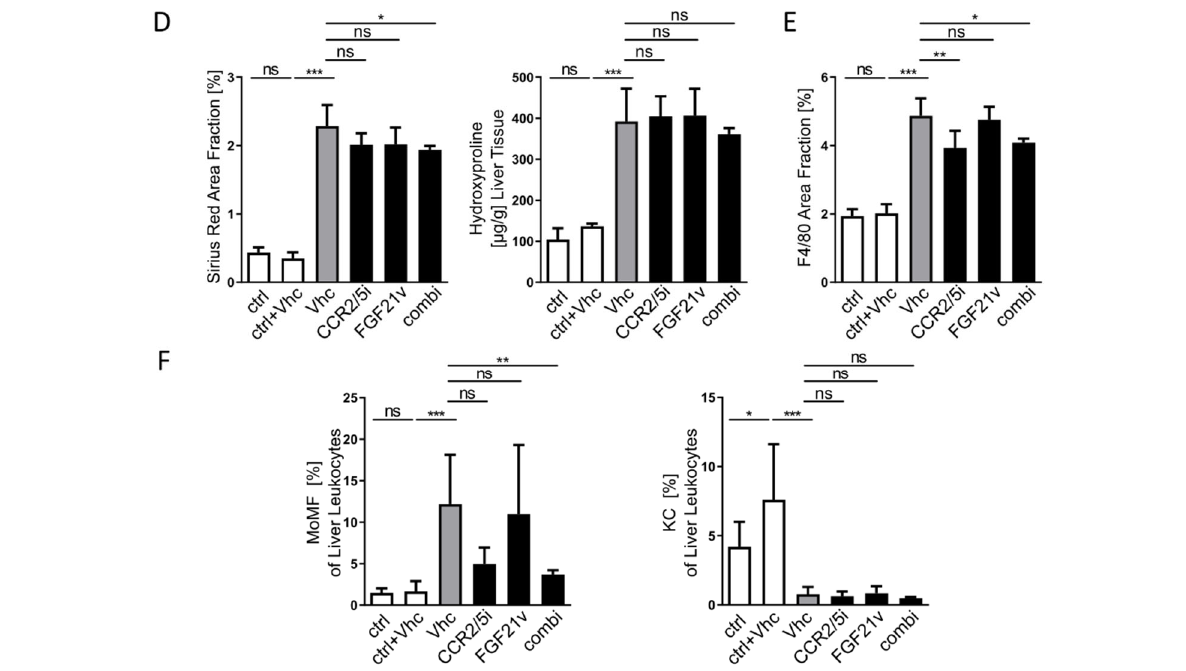
Figure 4. Beneficial effects of combination therapy after short term treatment. ( A ) Steatohepatitis and fibrosis were induced by CDAHFD (choline-deficient, amino acid-defined high-fat diet) over a total period of 8 weeks. Effects of pharmacologic treatment were assessed after administration of CCR2/CCR5 inhibitor (CCR2/5i) and/or PEG-FGF21 variant (FGF21v) over the last two weeks of in- jury induction. ( B ) Representative liver section of H&E, Sirius Red and F4/80 immunohistochemistry staining ( × 10 magnification; scale bars = 100 µ m). ( C , D ) Serum alanine transaminase (ALT) levels, NAFLD activity score, hepatic triglyceride and hydroxyproline content as well as quantification of Sirius Red area fraction display the liver phenotype. ( E , F ) Quantification of F4/80 positive area fraction and flow cytometrically determined monocyte-derived macrophages (MoMFs) and liver Kupffer cells (KC). All data are presented as mean SD ( n ≥ 6 per group) ns = non-significant, * p < 0.05, ** p < 0.01, *** p < 0.001 (one-way ANOVA with post-hoc